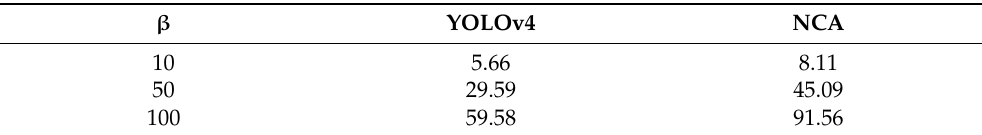
Figure 10. Confusion matrixes for ( A ): YOLOv4 ‐ based method and ( B ): NCA ‐ based method. TP—the model detected a lesion where it actually exists; FP—the model detected a lesion where it actually does not exist; FN—the model did not detect the lesion, where it actually exists. Table 4 shows the values of Precision, Recall, F 1 ‐ score for test set. Table 5. Values of F β at different significance values of β